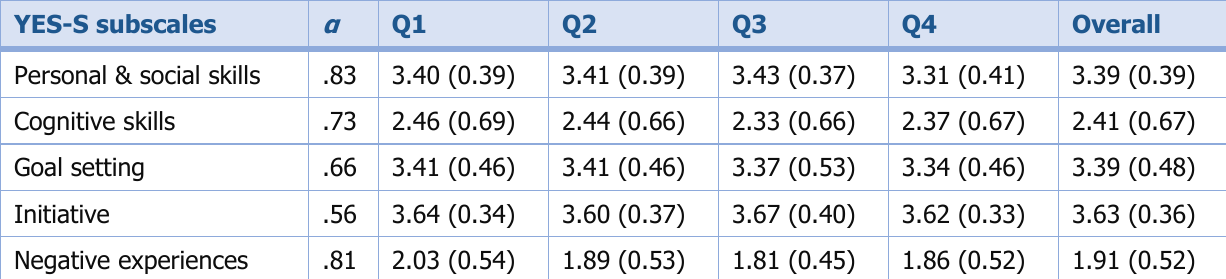
Table 1. Means (Standard Deviations) for YES-S Scores Based on Quartile of Birth YES-S subscales α Q1 Q2 Q3 Q4 Overall